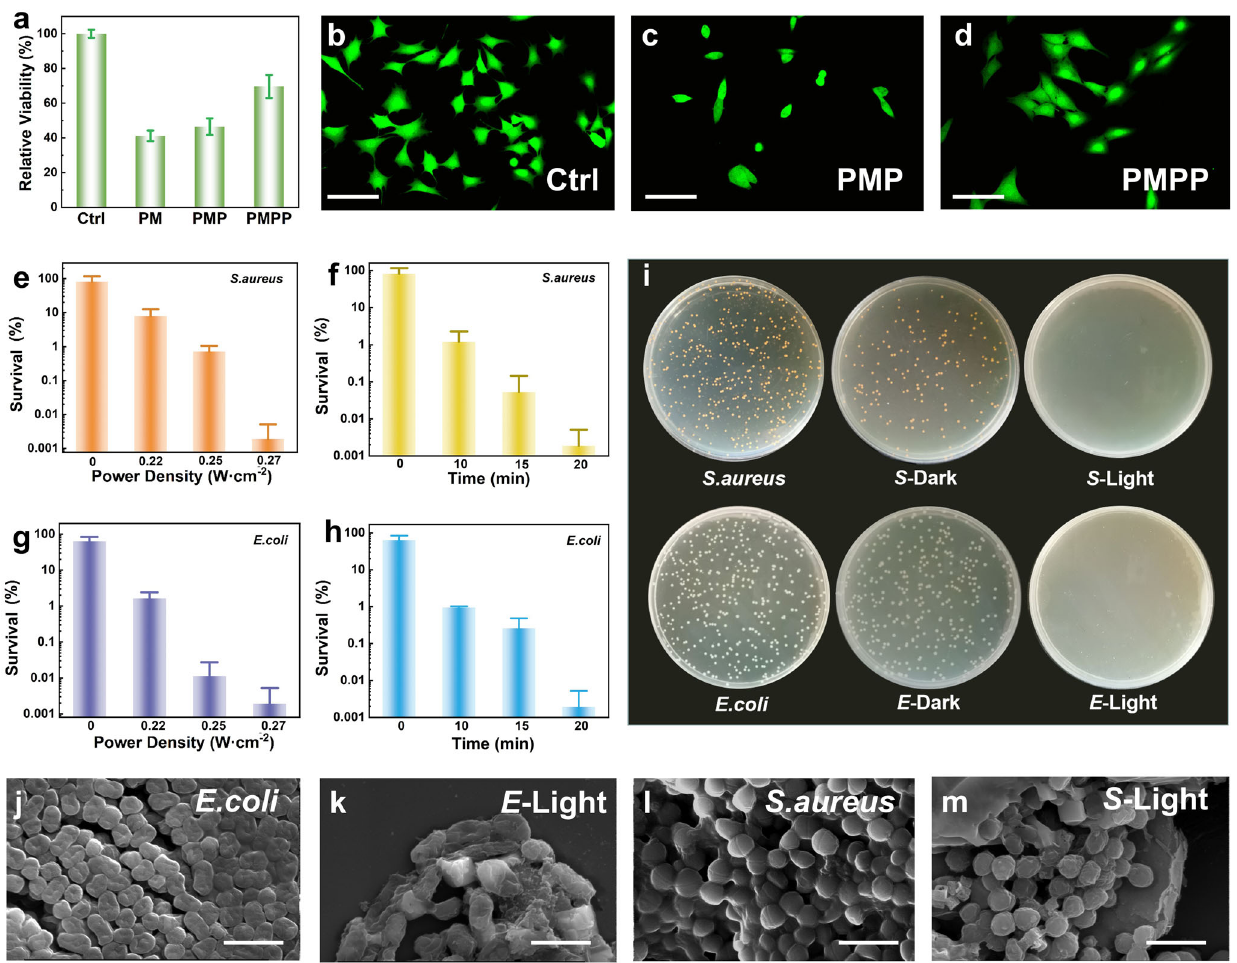
Fig. 7 Biocompatible and photothermal antibacterial performance of PMPPF electrical device. a Cell relative viability of NIH-3T3 cells treated by different samples (Error bars: s. d., n = 6). Typical fl uorescence microscopy image of mouse cells (NIH-3T3) after incubation for 1 day on the substrate of b Control, c PMP and d PMPP (Scale bars: 10 μ m). Survivability of e S. aureus and g E. coli after treatment with PMPPF under different power densities of IR laser. (Irradiation time = 20 min). Survivability of f S. aureus and h E. coli after treatment with PMPPF under different irradiation times of IR laser. (Power density = 0.27 W·cm − 2 ). i Digital images of agar plates used for the growth of E. coli and S. aureus exposed to PMPPF for 20 min under conditions with or without NIR (808 nm) laser irradiation. SEM images of untreated j E. coli and l S. aureus . SEM images of k E. coli and m S. aureus after treated with PMPPF. (Scale bars: 2 μ